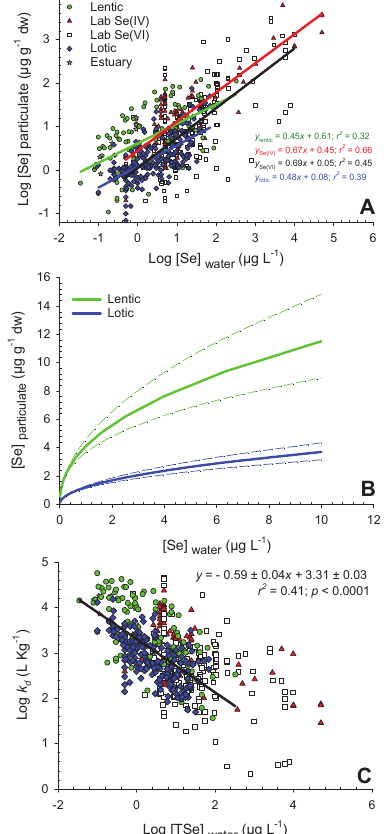
Figure 1. Panel ( A ) shows log-transformed selenium concentrations in particulate (Log [Se] particulate ; μ g g (cid:442) 1 dw) as a function of log-transformed water total dissolved selenium concentrations (Log [TSe] water ; μ g L (cid:442) 1 ) for lentic (green circles; n = 110), estuary (gray stars; n = 8), lotic (blue diamond; n = 195), selenate (white squares; n = 162), and selenite studies in the laboratory (red triangles; n = 94). Regressions are presented except for estuaries and equations are presented in panel A ( p -value < 0.0001). Panel ( B ) shows the same regressions (± dashed standard errors) as in panel A for lentic and lotic systems but on a normal scale at relatively low aqueous Se concentrations (0-10 μ g L (cid:442) 1 ). Panel ( C ) shows log-transformed partition coefficient (Log k d ; L kg (cid:442) 1 ) as a function of log-transformed water total dissolved Se concentrations (Log [TSe] water ; μ g L (cid:442) 1 ) for the same systems as in panel A (see legend in panel A ). The regression in panel C is for all field studies.